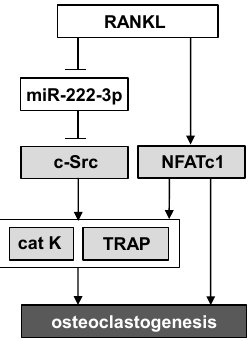
Figure 10. Schematic illustration of the proposed role of miR-222-3p in RANKL-stimulated osteoclastogenesis. Of note, cat K = cathepsin K.